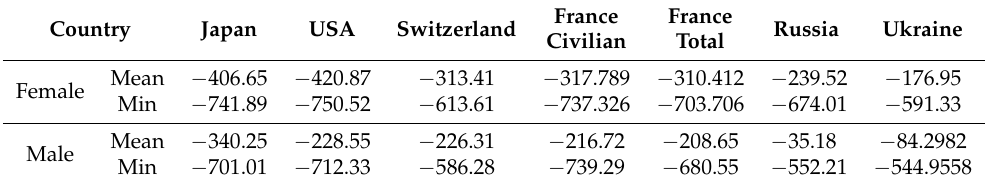
Table 1. AIC improvement ∆ AIC between the Heligman–Pollard model and DLGC.